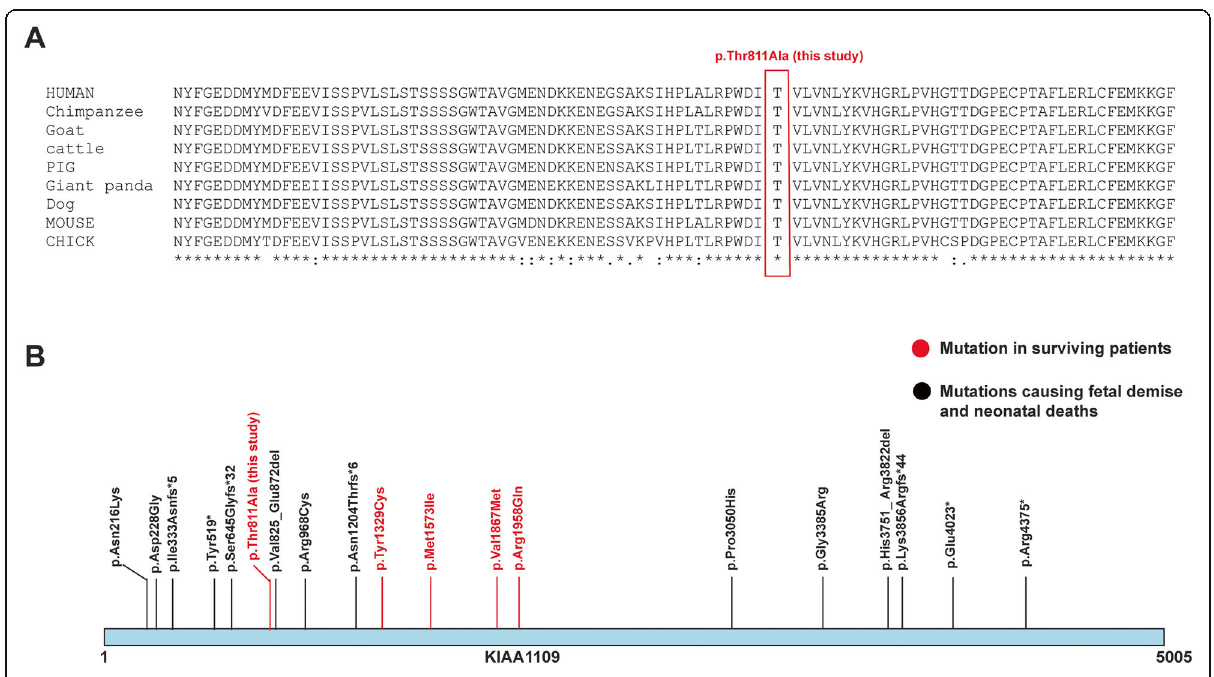
Fig. 3 Conservation analysis and protein altering mutations of KIAA1109. a conservation analysis showing the conservation of p.Thre811Ala mutation of KIAA1109 identified in this study across species. b Depiction of known mutations and novel mutation identified in this study causing Alkuraya-Kucinskas syndrome. Mutations shown in red are the mutations in surviving patients and those shown in black are the mutations identified in patients with fetal demises and neonatal